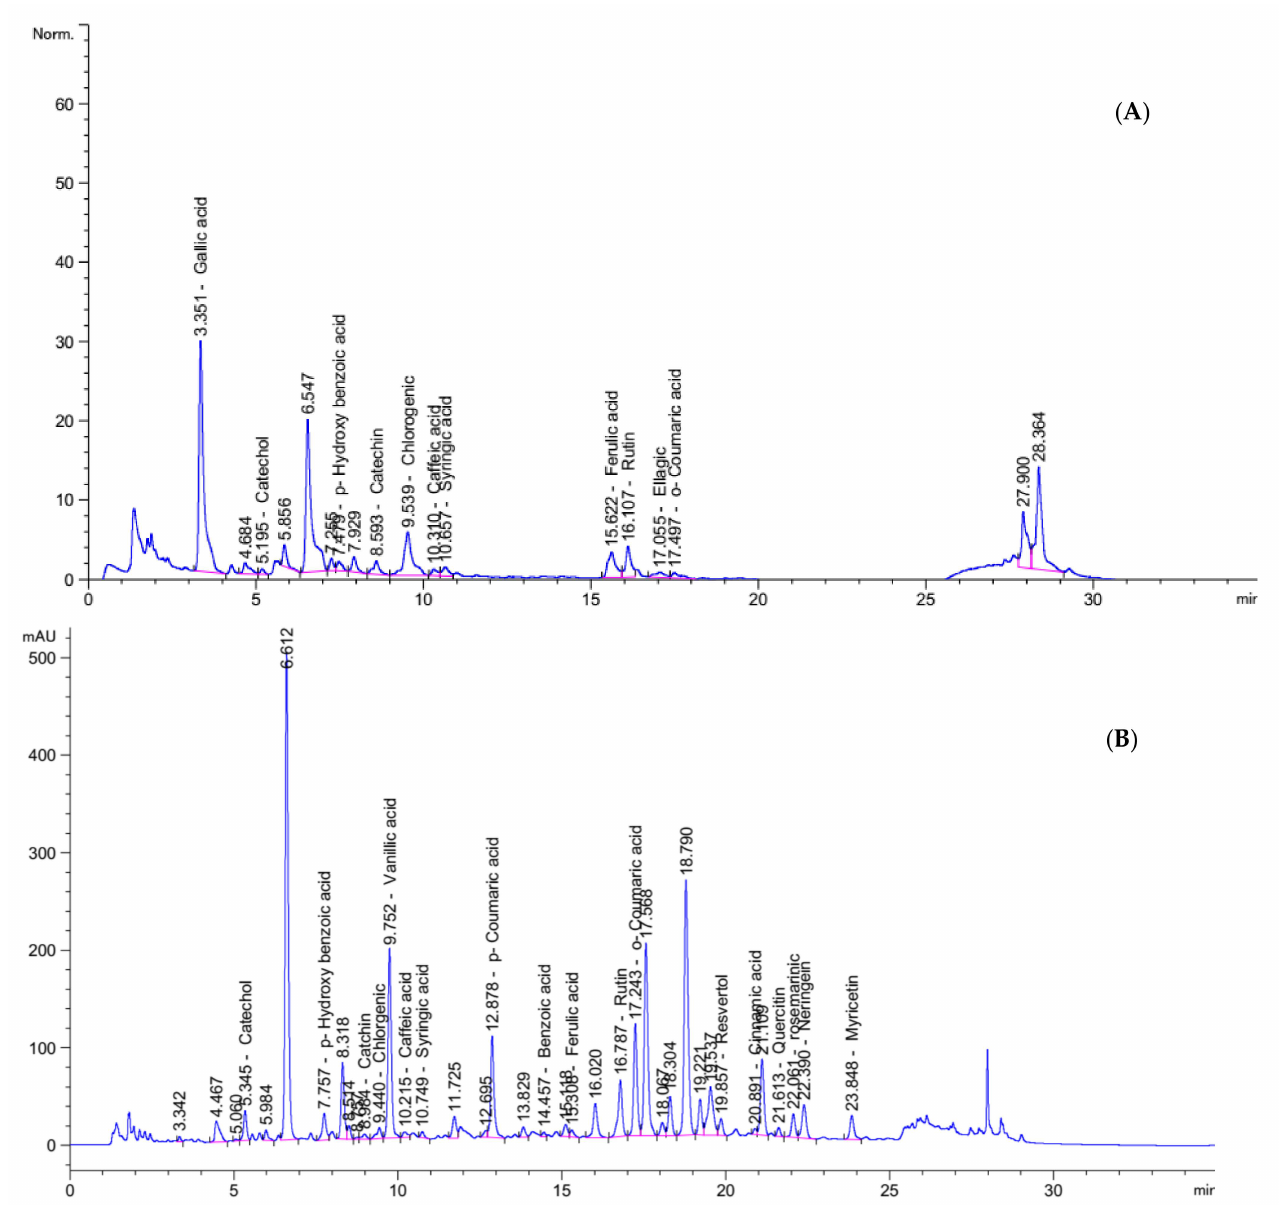
Figure 2. HPLC analysis of polyphenolic profiles of ( A ) IHM and ( B )